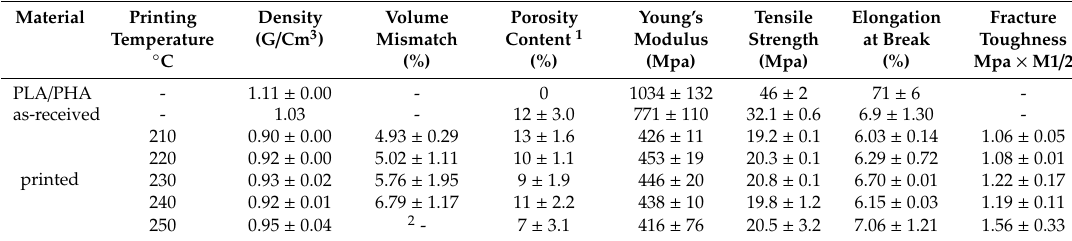
Table 2. Tensile properties of as-received and printed Wood-PLA / PHA.